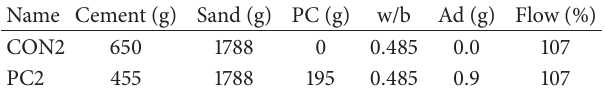
Table 3: Mortar mixture proportions for shrinkage determination.